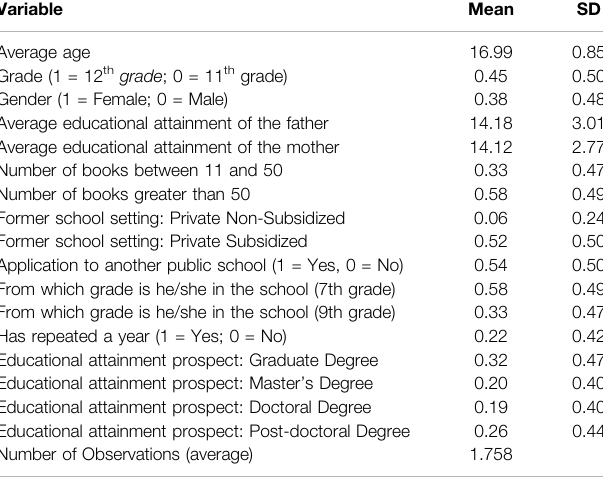
TABLE 3 | (Selected) descriptive statistics of the